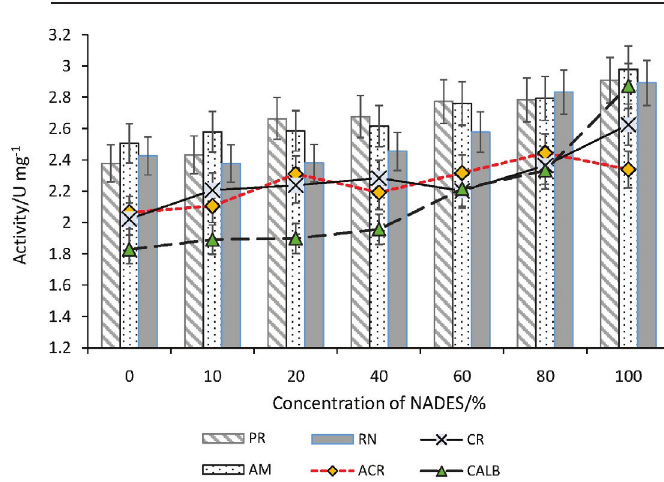
Fig. 5a – Activity of lipases at different concentrations of aqueous NADES3